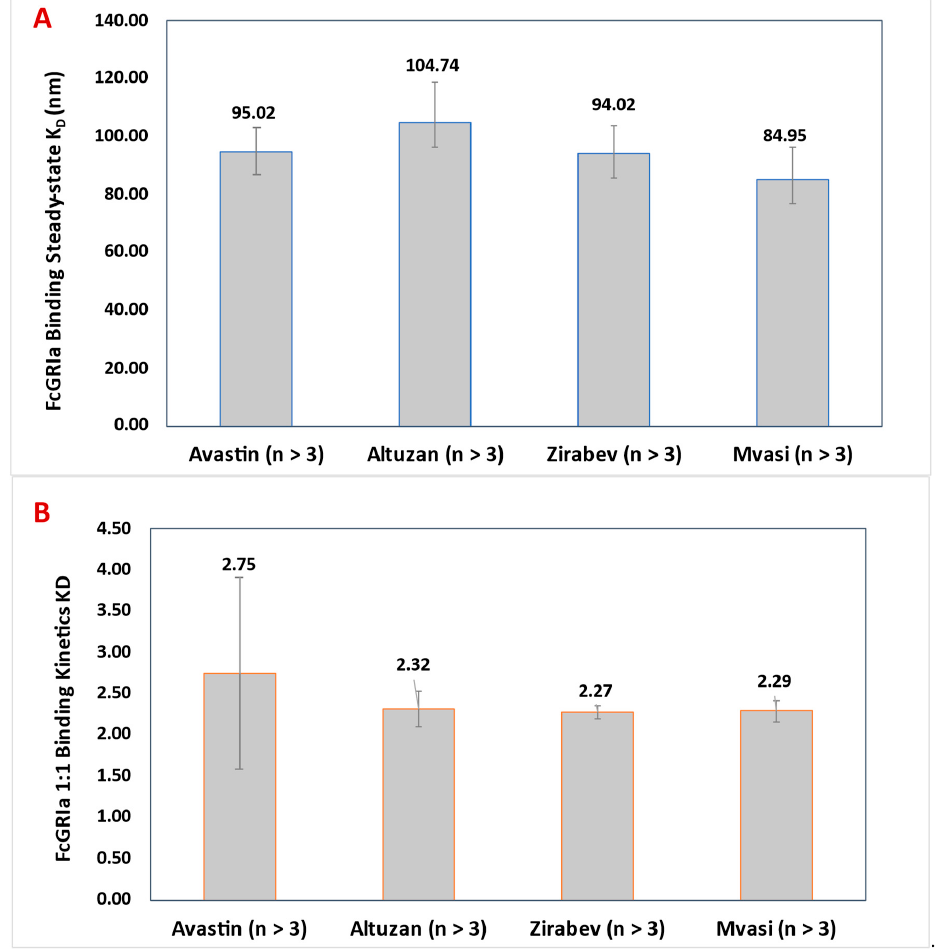
Figure 7. Fc γ RIa binding analysis of Bevacizumab and biosimilars. ( A ) Steady-state interaction of the samples with the Anti-His capture method was represented as the mean of at least three measurements. ( B ) Langmuir 1:1 binding model based SPR results for Fc γ RIa binding. The data represented the mean of at least three independent measurements. There was no significant difference between Avastin, and other samples based on the Single-way ANOVA analysis ( p < 0.05).